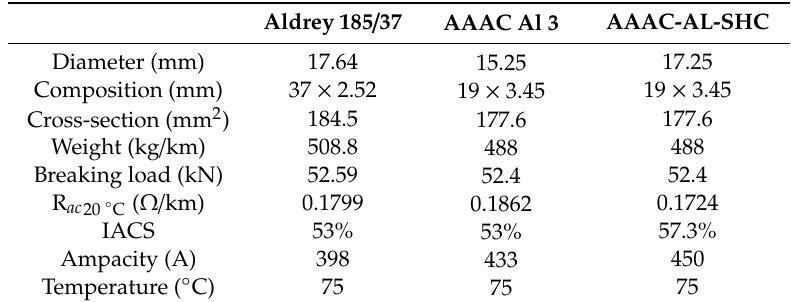
Figure 7. Section of the AAAC-Super High Conductivity (SHC) conductor with diameter 17.25 mm.